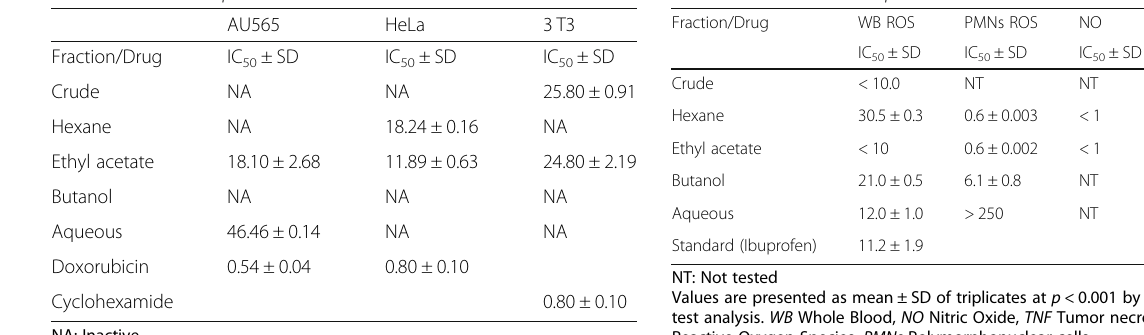
Table 3 DPPH Radical Scavenging Activities of methanolic crude extract and fractions of A. precatorius roots Fraction/Standard